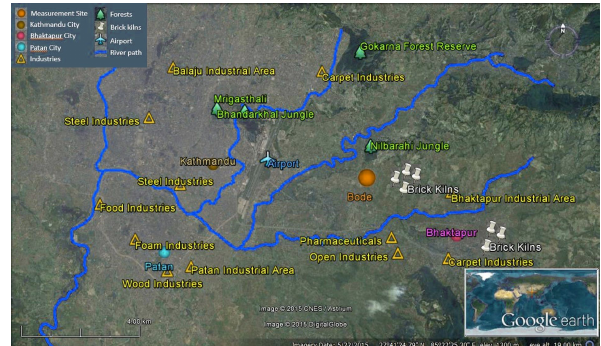
Figure 1. Location of the measurement site (Bode, orange circle) along with surrounding cities (Kathmandu, brown circle; Patan, turquoise circle; Bhaktapur, pink circle), brick kilns (white mark- ers), major industries (yellow triangles), forested areas (green tree symbols), the airport (blue marker) and major river paths (sky blue) in the Google Earth image of the Kathmandu Valley (obtained on 22 May 2015 at